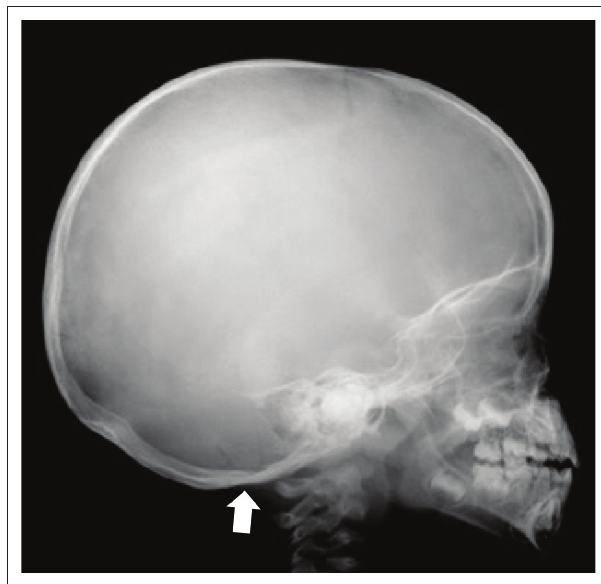
FIGURE 6: Two-year-old female with a linear occipital bone fracture (white arrow) on a lateral skull view. This is a low-specificity fracture for non-accidental